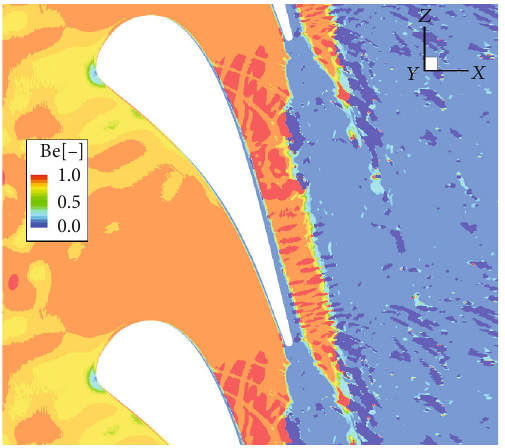
Figure 18: Local Bejan number distribution of MUR129. Figure 17: Local Bejan number distribution of